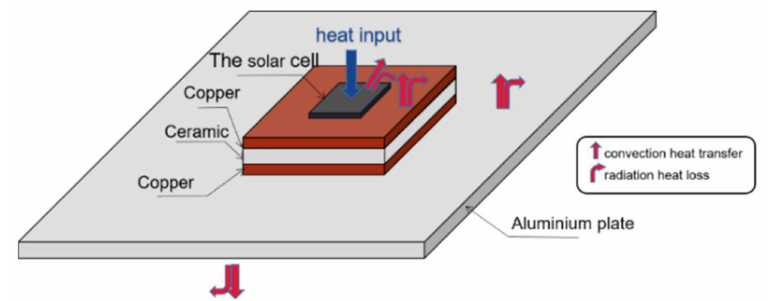
Figure 3. Heat dissipation diagram of the receiver.